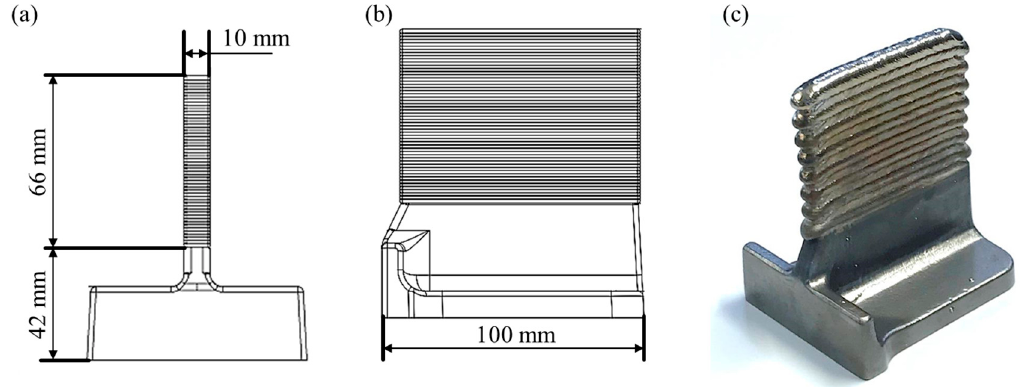
Figure 2. Drawing of the final pre-form with dimensions. Front view ( a ), side view ( b ), final appearance of the hybrid near-net shape demonstrator ( c ).